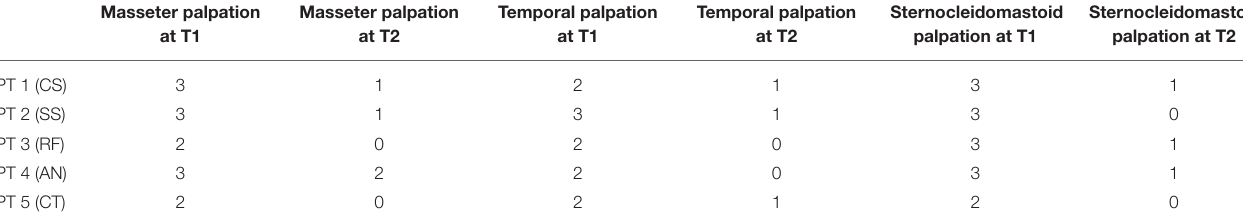
TABLE 2.1| Masseter, temporal, and sternocleidomastoid palpation test after treatment compared with baseline. Masseter palpation Masseter palpation Temporal palpation Temporal palpation Sternocleidomastoid at T1 at T2 at T1 at T2 palpation at T1